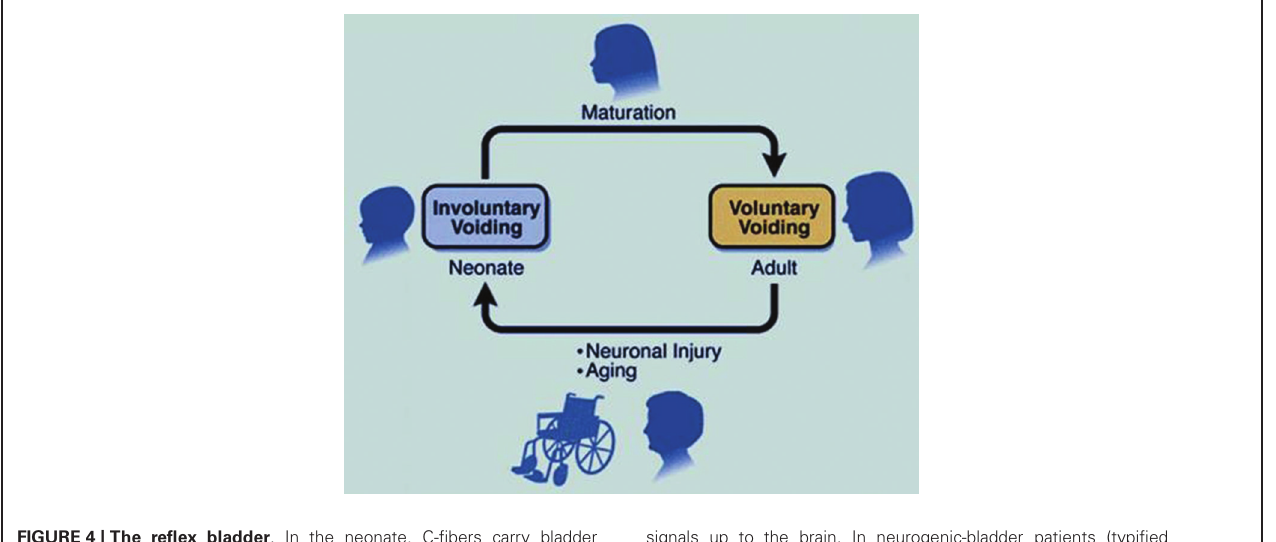
signals up to the brain. In neurogenic-bladder patients (typified following spinal injury), a rapid deterioration of this descending inhibitory control occurs, ”unmasking” the C-fiber reflex beneath. The more gradual emergence of this reflex, due to idiopathic loss of descending C-fiber inhibition, may account for the development of many LUT symptoms (as conceived by WC de